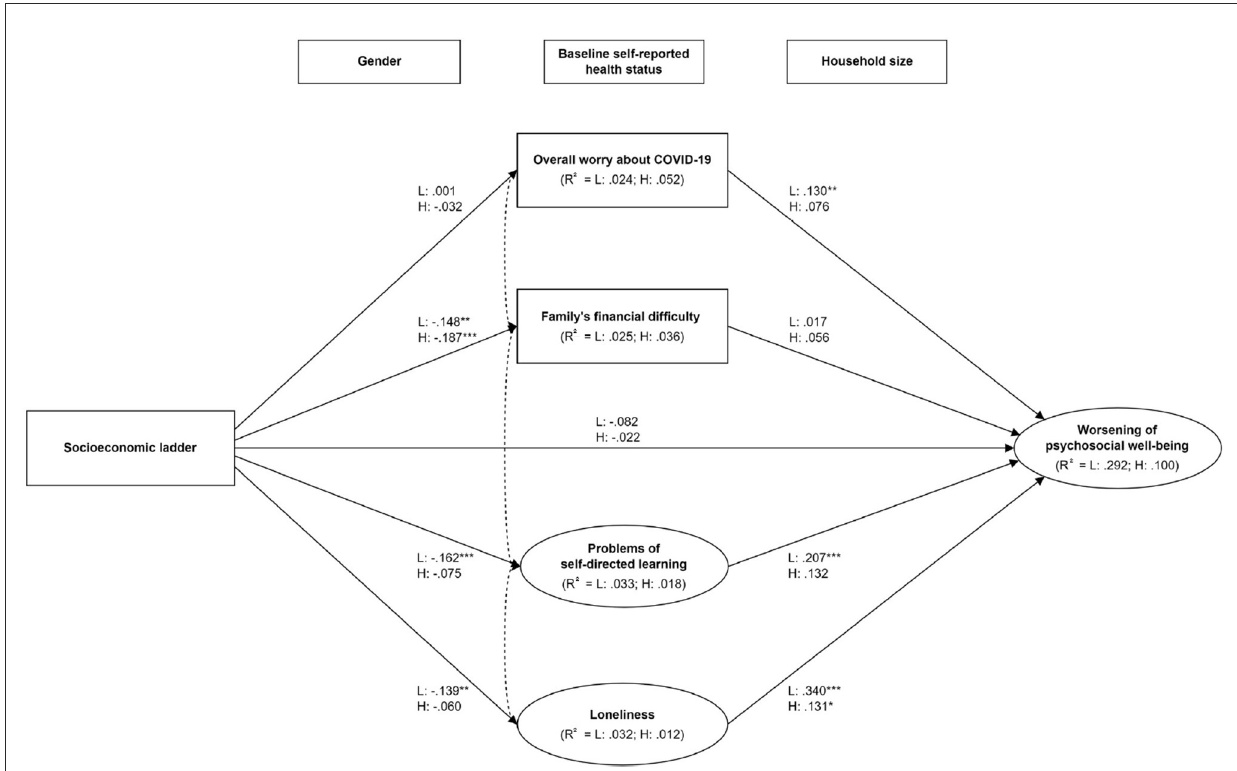
FIGURE2 The mediating pathways between socioeconomic position and the worsening of psychosocial wellbeing by resilience levels. L: Lower resilience group; H: Higher resilience group. * p < 0.05; ** p < 0.01; *** p < 0.001. Model was adjusted for gender, household size, and baseline self-reported health status. Covariance was specified in each of the possible pairs of mediators. The dotted double arrows between mediators are simplified for better